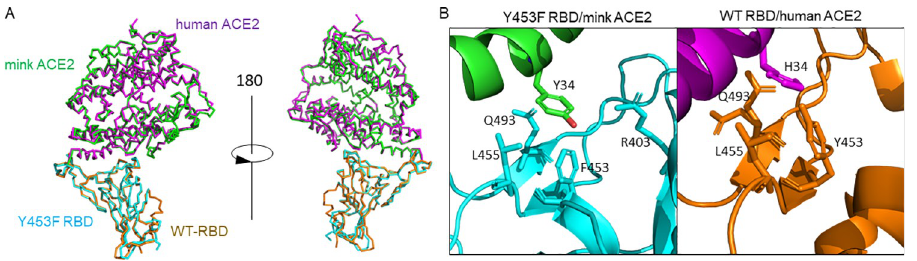
Fig 3. Structural comparison of Y453F RBD/mink ACE2 and WT RBD/human ACE2 complexes. (A)The overall structure is shown as ribbons. The Y453F-RBD is shown in cyan and mink ACE2 in green. The WT-RBD and human ACE2 are shown in magenta and orange, respectively. (B) Interaction residues around position 34 of human and mink ACE2. Left: complex of Y453F RBD/mink ACE2. Right: complex of WT RBD/human ACE2. RBD is shown in cyan, ACE2 in green. Contact residues are shown as sticks which were defined using a distance cutoff of 4 Å . The PDB code for WT-RBD/human ACE2 complex is 6M0J[21].